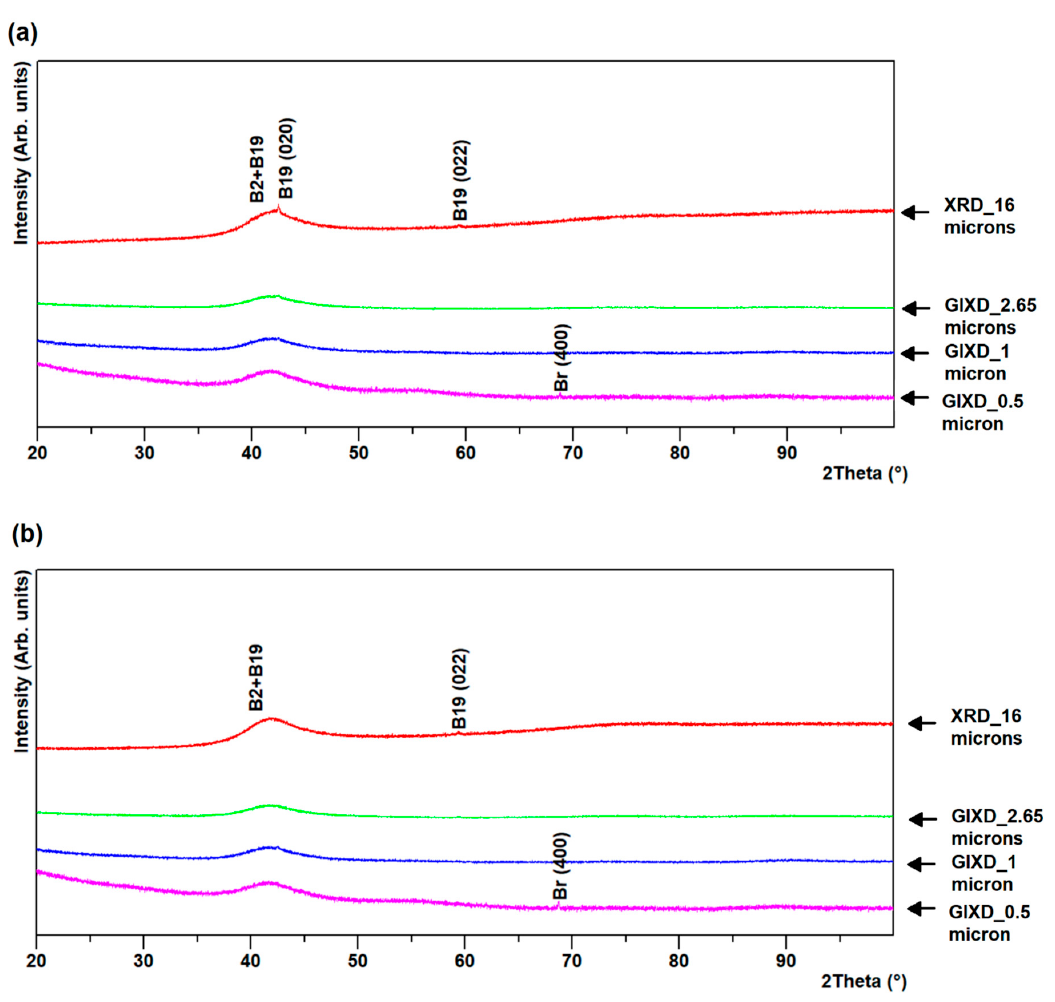
Figure 4. GIXD for R0 ribbon ( a ) air- and ( b ) wheel-side.